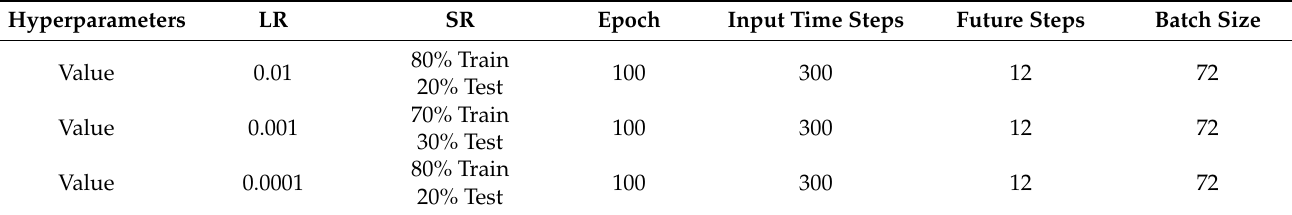
Table 5. The best hyperparameters based on our empirical study.